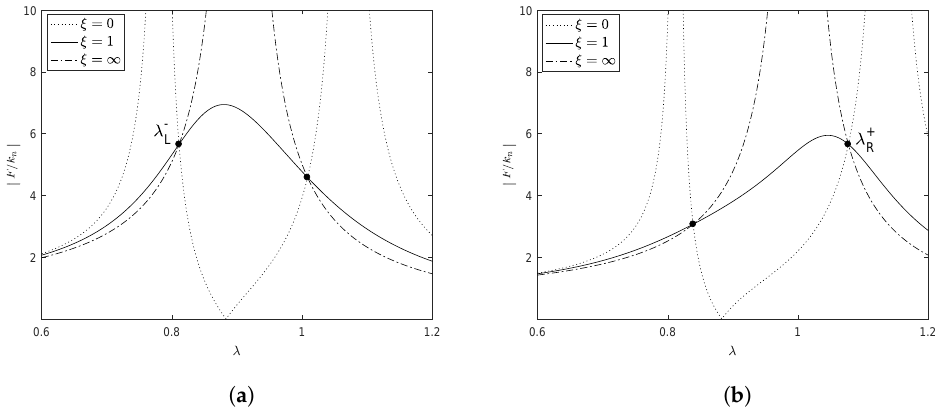
Figure 5. Frequency responses of an uncertain primary system controlled by a TMDI corresponding to three damping levels: ( a ) δ = − β and ( b ) δ = + β . The set of parameters used for the simulation was µ = 0.05, ν = 0.05, and β = 10% and f was evaluated by means of Equation (36). Dotted line: ξ = 0, solid line: ξ = 1, and dashed-dotted line: ξ = ∞ . The coordinates of the leftmost and rightmost fixed points read as, respectively, ( 0.81,5.66 ) , and ( 1.08,5.66 )